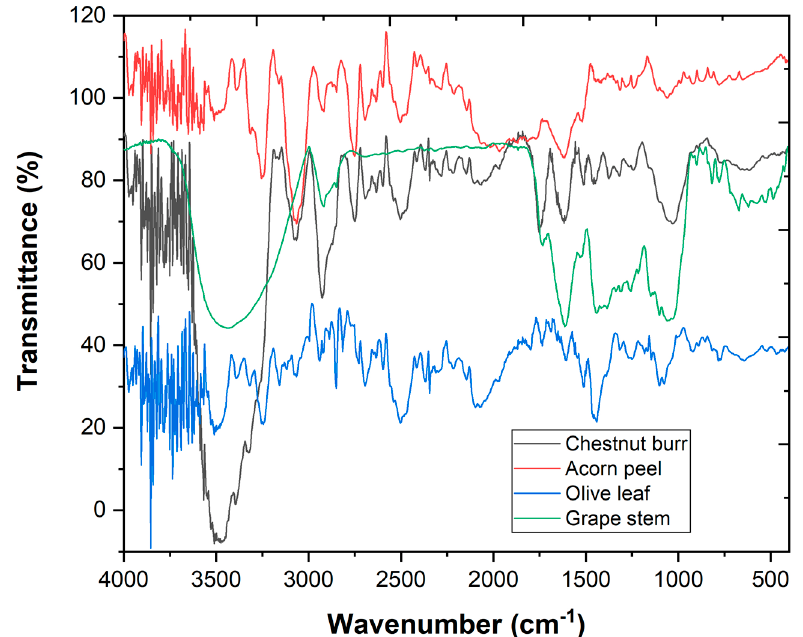
Figure 3. FTIR spectra of the four plant-based coagulants.